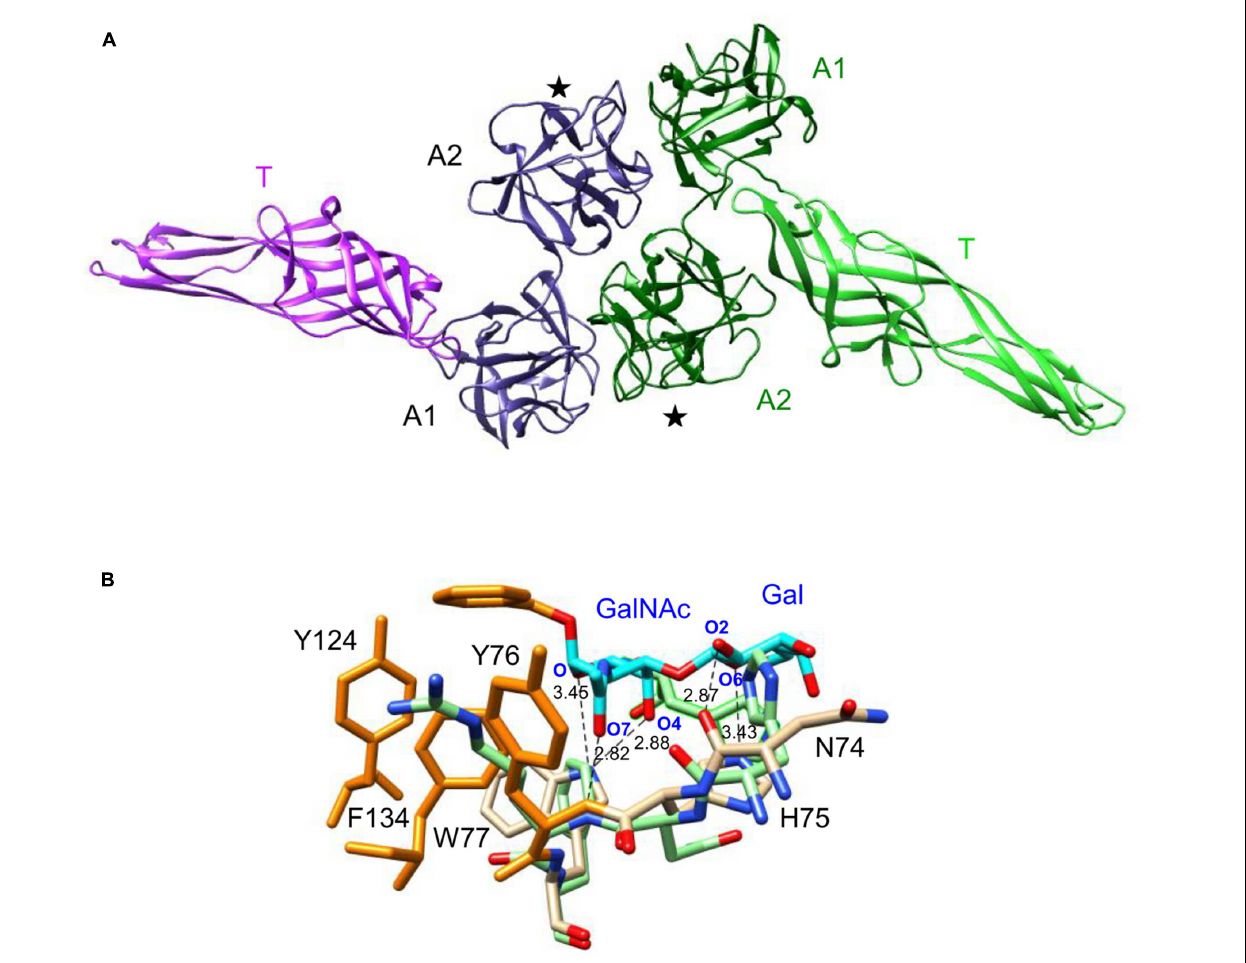
FIGURE 8 | Molecular modeling of AAT4. (A) Ribbon diagram of the dimeric structure of AAT4. Both monomers, colored violet and green, respectively, consist of two amaranthin domains (A1, A2), linked to an aerolysin-like domain (T). Domains A2 contain a carbohydrate-binding site ( (cid:70) ). (B) Network of H-bonds (dashed black lines) anchoring the benzoyl T-antigen disaccharide (cyan and orange stick) to the carbohydrate-binding site of the amaranthin lectin. A stacking interaction occurs between the benzoyl ring and aromatic residues Y76, Y124, and F134 (orange sticks) located in the vicinity of the active site. The H-bond distances are indicated in Ångströms. Amino acid residues colored pale green correspond to residues of the AAT4 A2 domain, homologous to the amino acid residues forming the carbohydrate-binding site of